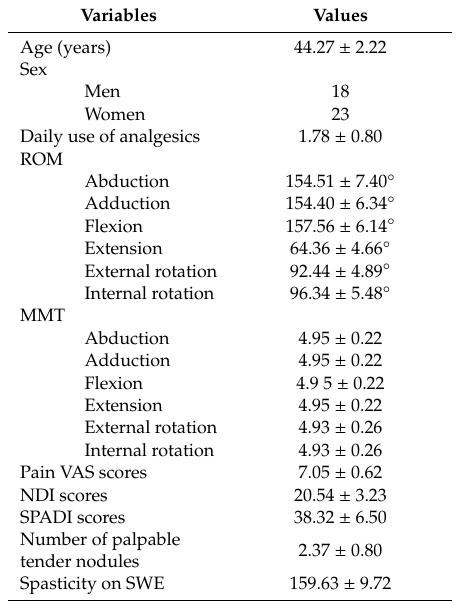
Figure 3. The study flow chart. MTrPs, myofascial trigger points. MPS, myofascial pain syndrome. DM, diabetes mellitus. CNS, central nervous system. SCI, spinal cord injury. SWE, shear wave elastography. US, ultrasound. The 41 eligible patients were randomized to either the trial group ( n = 21) or the control group ( n = 20), all of whom completed the current study. Table 1. Baseline characteristics of the patients ( n = (cid:3)(cid:3)